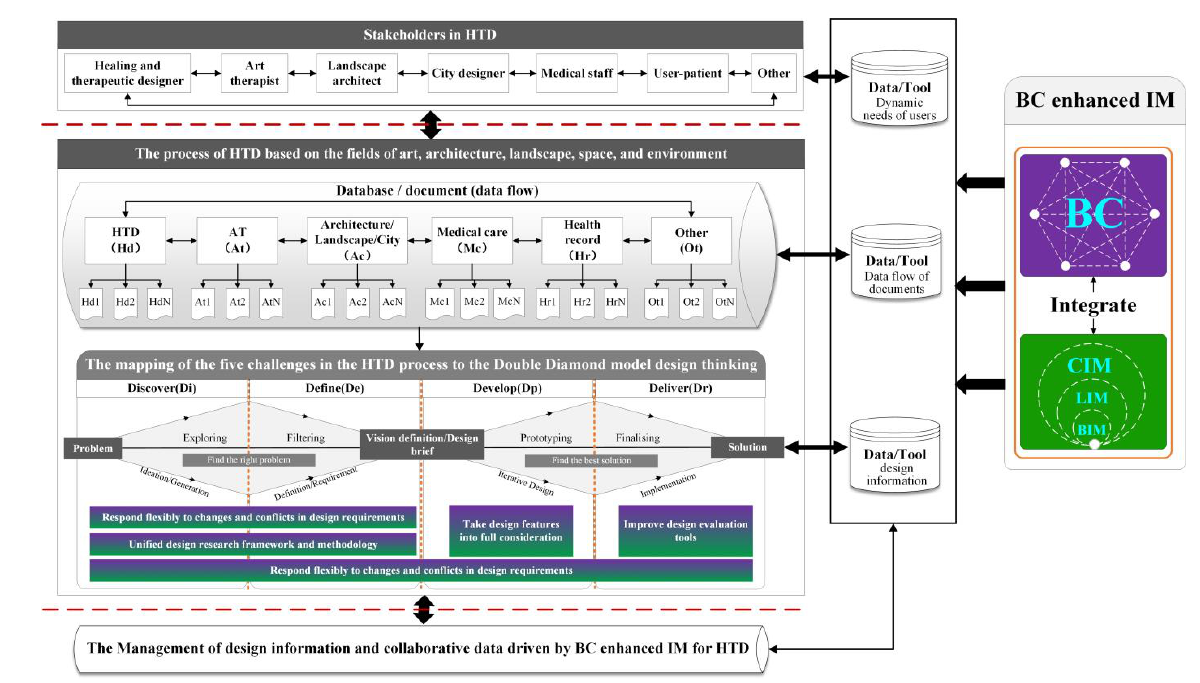
Figure 7. The potential roles of BC enhanced information modeling (IM) in addressing HTD chal- lenges (generated by authors).